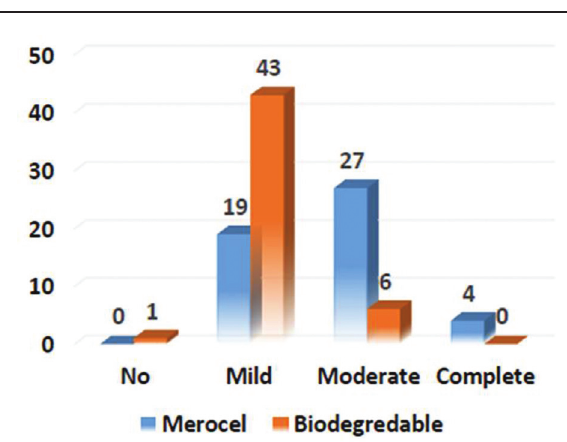
Bar chart illustrating postoperative nasal obstruction while the pack- ing in place.